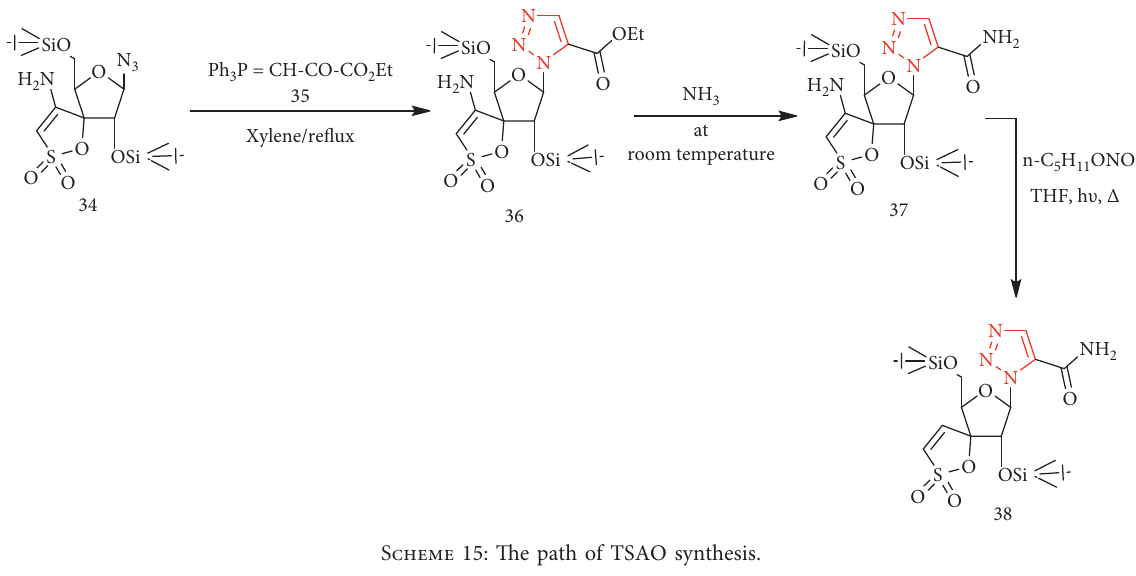
Scheme 15: The path of TSAO synthesis.